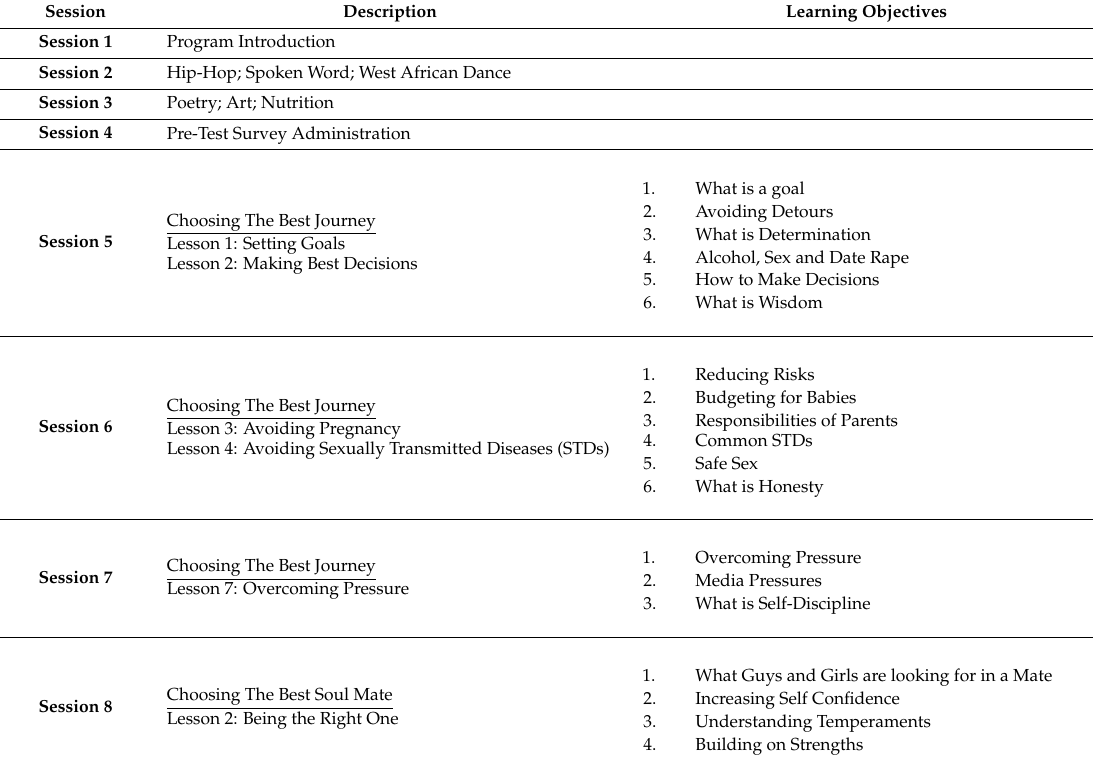
Table 1. 2 HYPE Abstinence Club Curriculum